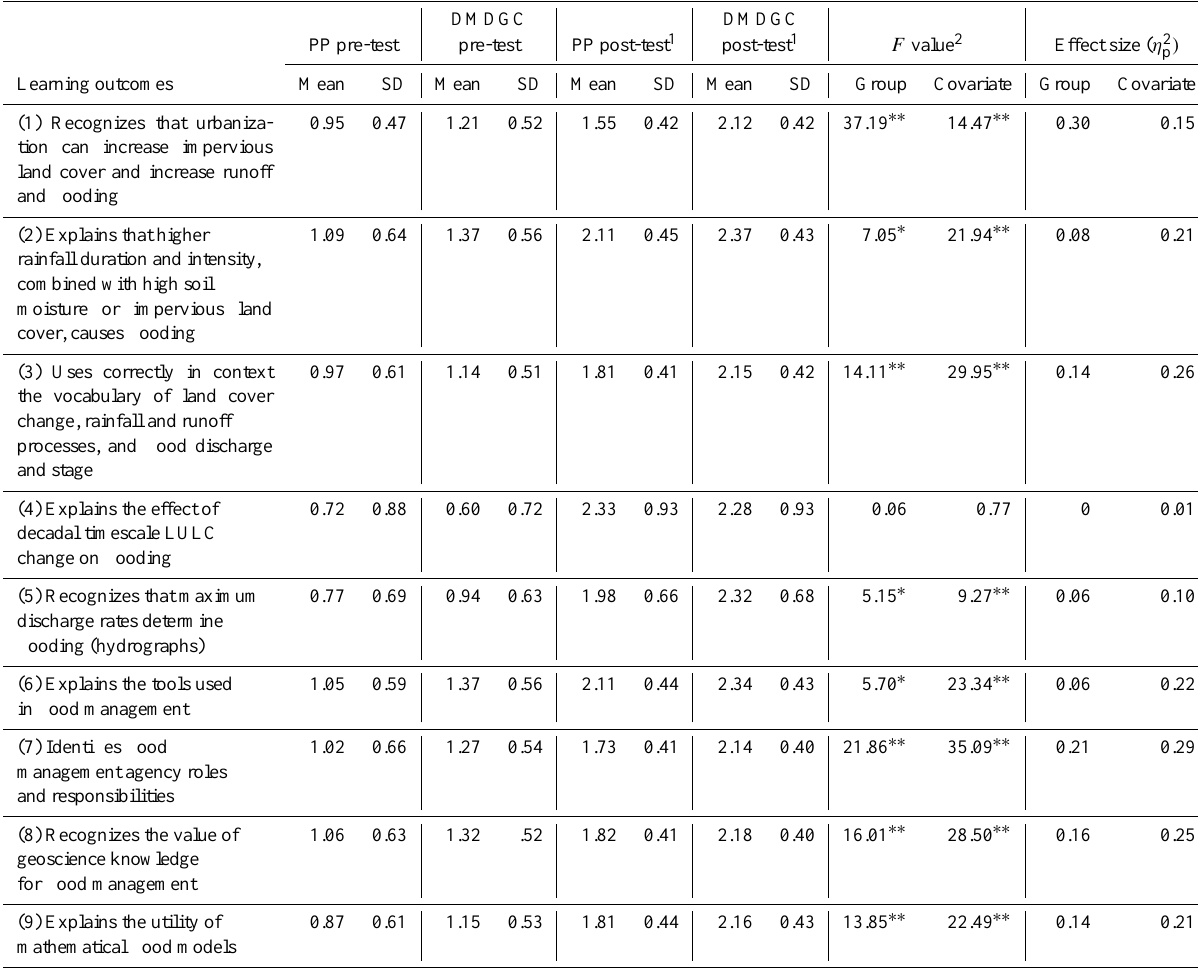
Table 3. Descriptive and inferential statistics for all